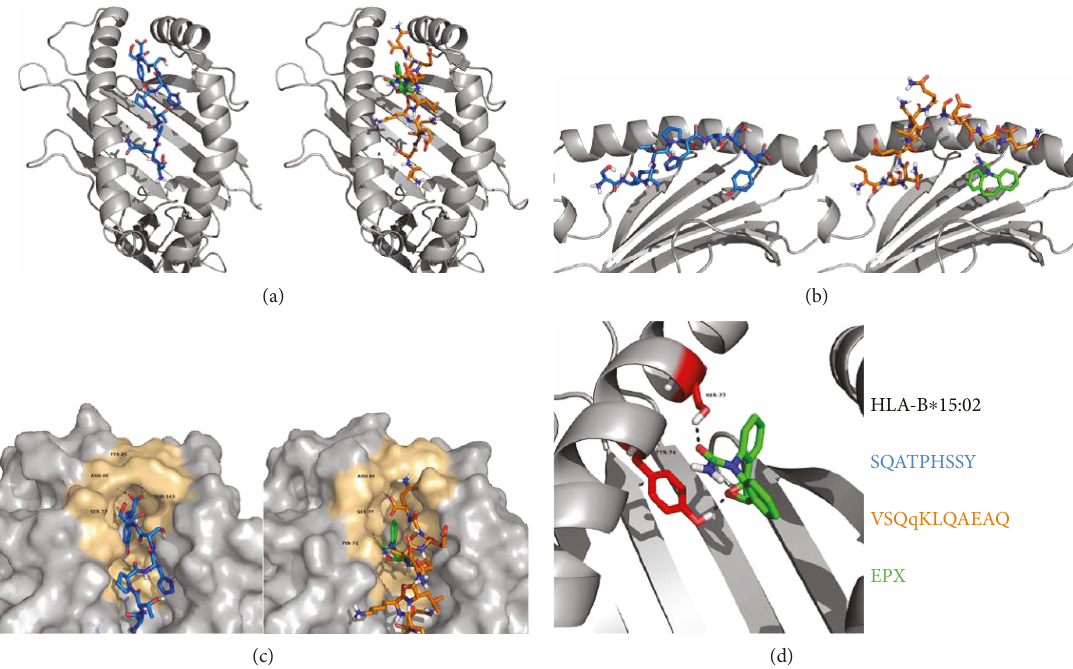
Figure 5: Modelling of peptides bound to empty and EPX bound HLA ∗ B15:02. The homology model of HLA-B ∗ 15:02 (grey) is based on the structure of HLA-B ∗ 15:01 (1XR8). The peptide SQATPHSSY (blue) could be solely detected without treatment, whereas following treatment with EPX (green), the peptide VSQqKLQAEAQ (orange) was detected. (a) Top view on the PBR of the pHLA complex in the absence and presence of EPX. (b) Side view on the PBR, the alpha helix of the alpha 2 domain is not shown. (c) Surface model of peptides and EPX binding to the F pocket (colored brownish). The AAs interacting with the peptide or the drug via hydrogen bridge bonds are depicted. (d) The oxygen atom in the carboxamide moiety of EPX interacts with two AAs of the F